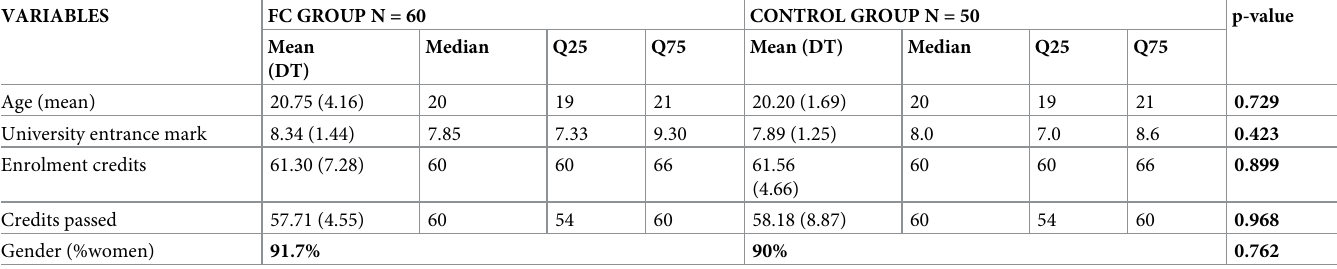
Table 2. Baseline comparison of the groups using variables of gender, age, university entry mark and credits passed so far.